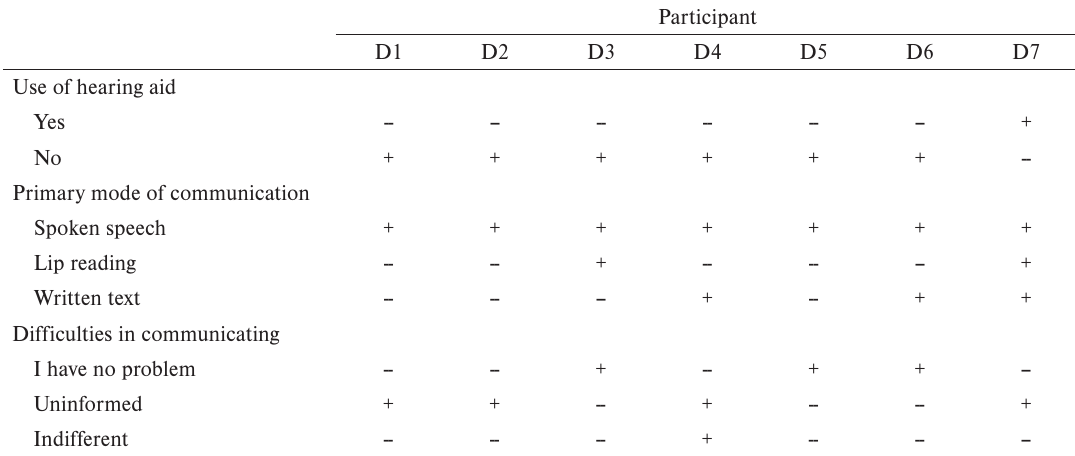
Table 2 Communication and hearing